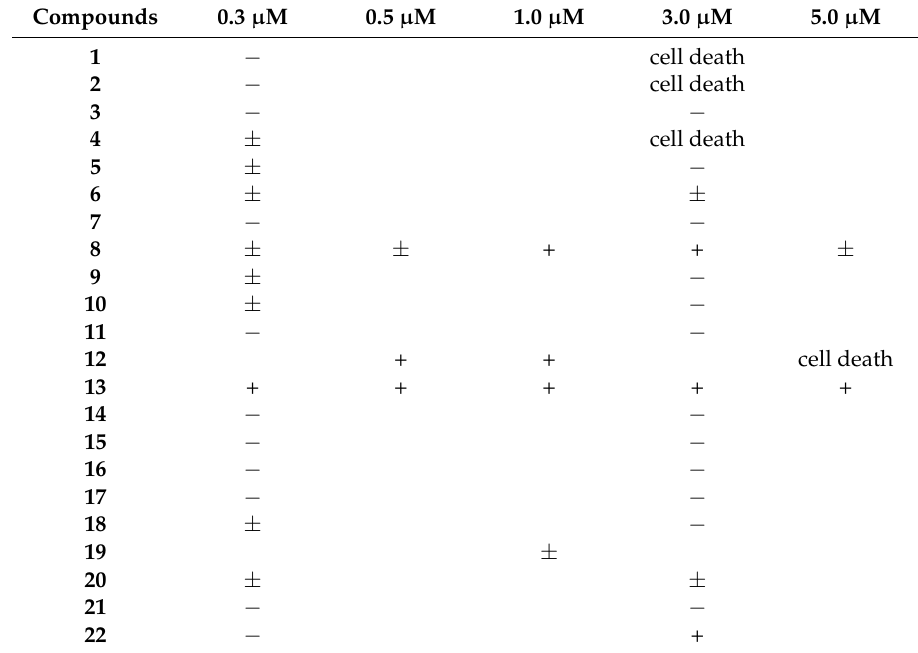
Figure 3. Effects of compounds 13 and dibutyryl cAMP (db cAMP) on neurite outgrowth from neuro2a cells. Neuro2a cells were treated with test compounds (5 mM db cAMP or 0.5 µM compound 13 ) for 48 h, and then morphological images were captured by phase-contrast microscopy ( A ). Cells were randomly chosen for counting neurite-bearing cells ( n = more than 100 cells per group) ( B ). Significance difference in values between the sample-treated and non-treated cells: *** p < 0.001 (one-way ANOVA followed by the Dunnett’s multiple comparison test). Table 1. Effects of carbazole derivatives on neurite outgrowth in neuro2a cells. Cells were treated with carbazole derivatives at the indicated concentrations for 48 h.